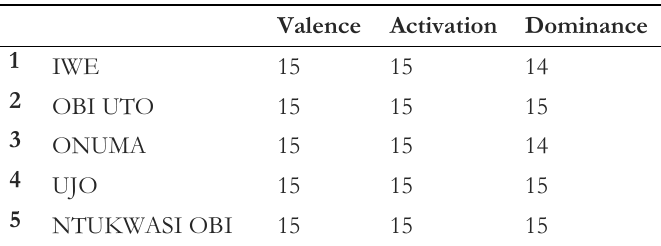
Table 5. Sample result of bad data